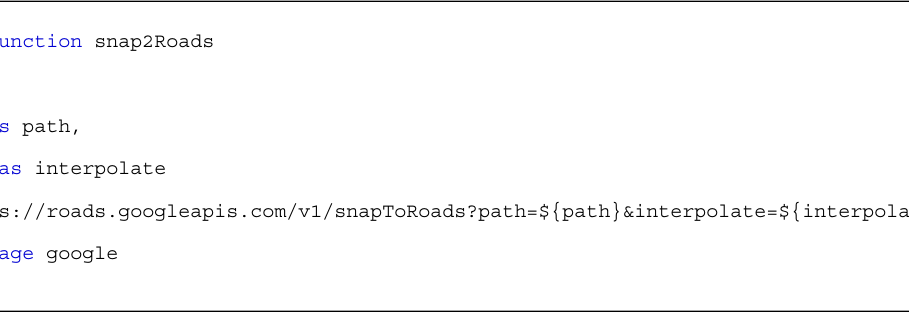
Scheme 10. Example of CREATE-FUNCTION clause.